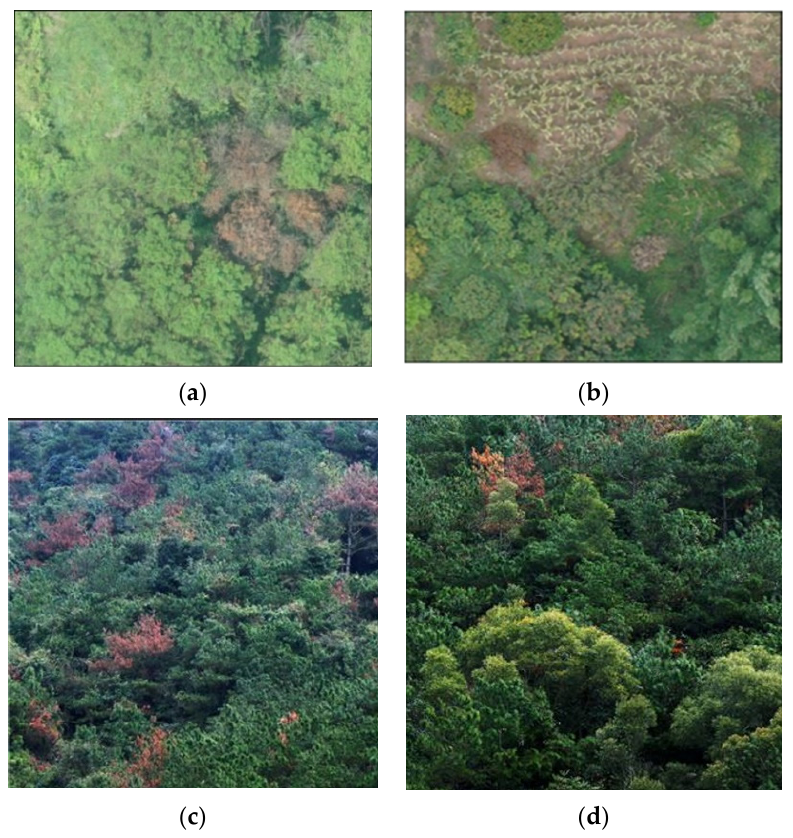
Figure 4. Collected images of pine wilt nematode trees. ( a ) DJI M600 of Figure 1; ( b ) DJI M600 of Figure 2; ( c ) DJI Royal 2 of Figure 1; ( d ) DJI Royal 2 of Figure 2.